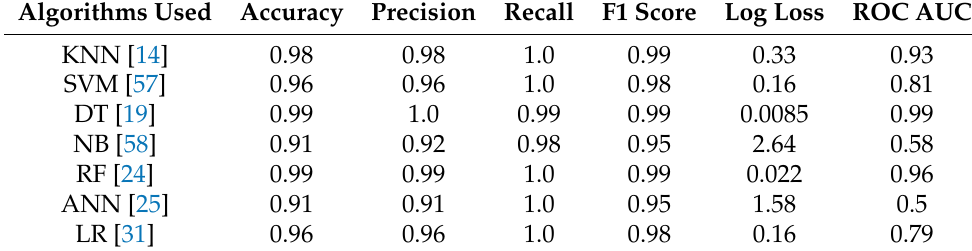
Key logging: Table 21 shows the results of Key logging data. DT is the best model as it has the best log loss and ROC AUC scores combined with perfect precision while having high metric scores. Table 21. Key logging results.